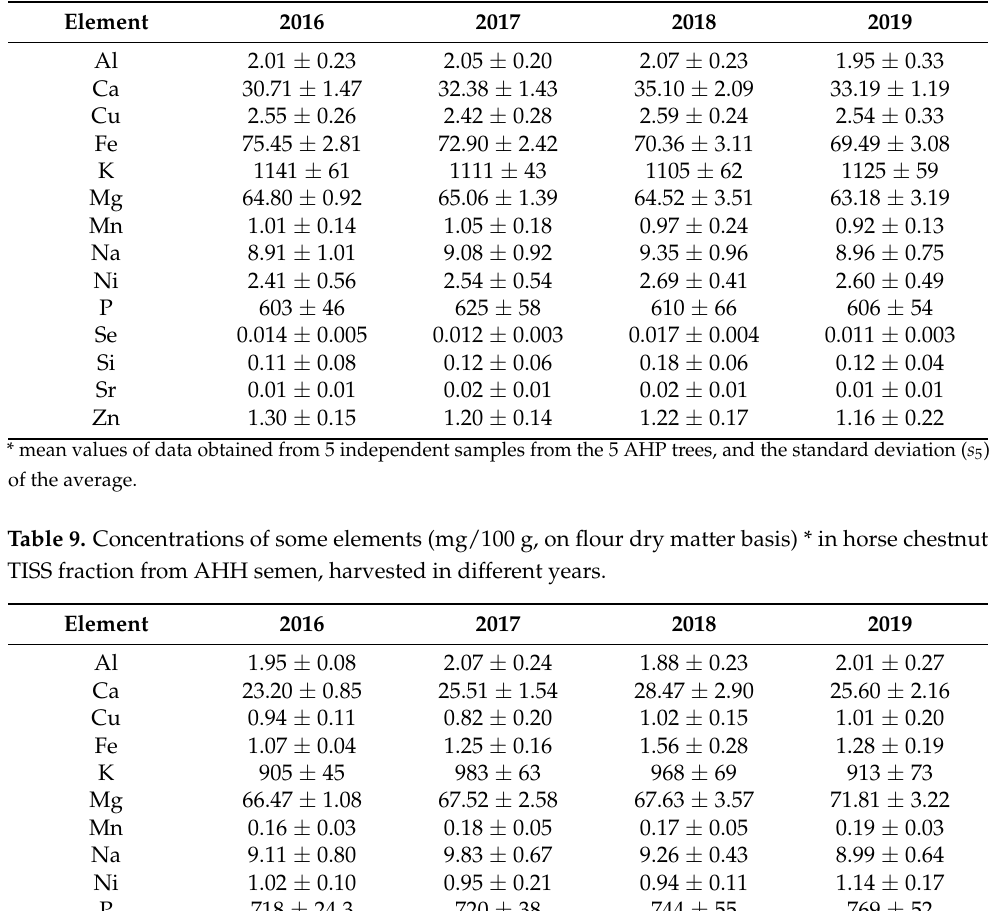
Table 8. Concentrations of some elements (mg/100 g, on flour dry matter basis) * in horse chestnut total inorganic soluble salts (TISS) fraction from AHP semen, harvested in different years. Element